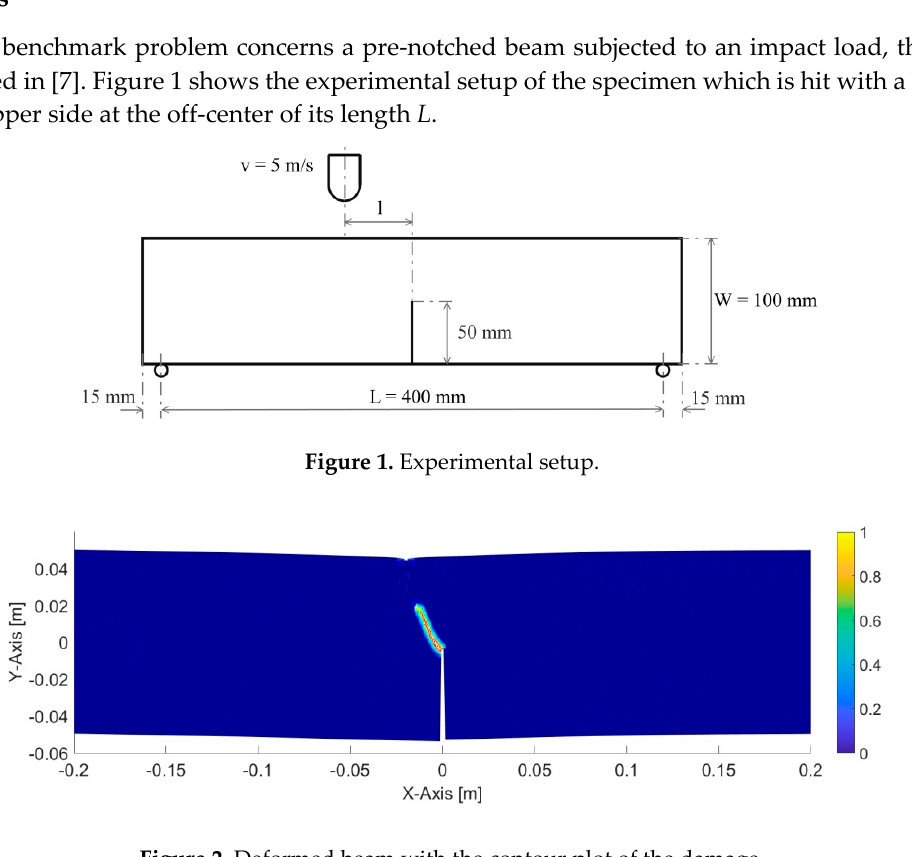
Figure 2. Deformed beam with the contour plot of the